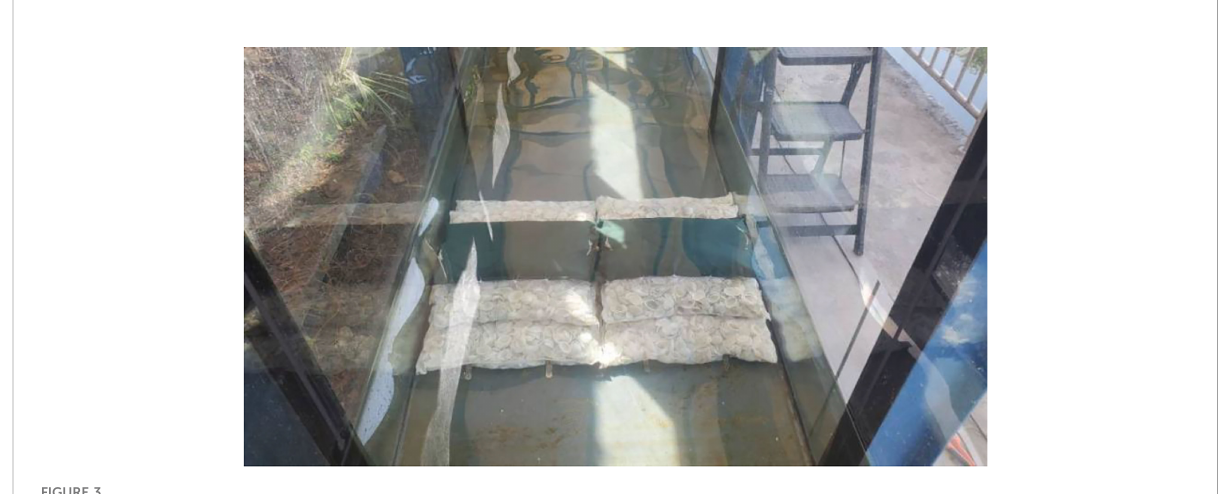
FIGURE 3 M1 physical model.